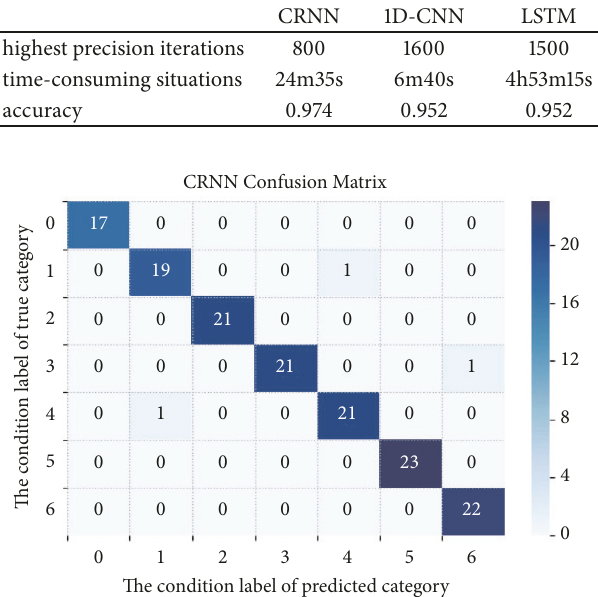
Figure 9: The confusion matrix of CRNN. The definition of the condition label of each fault is shown in Table 1.